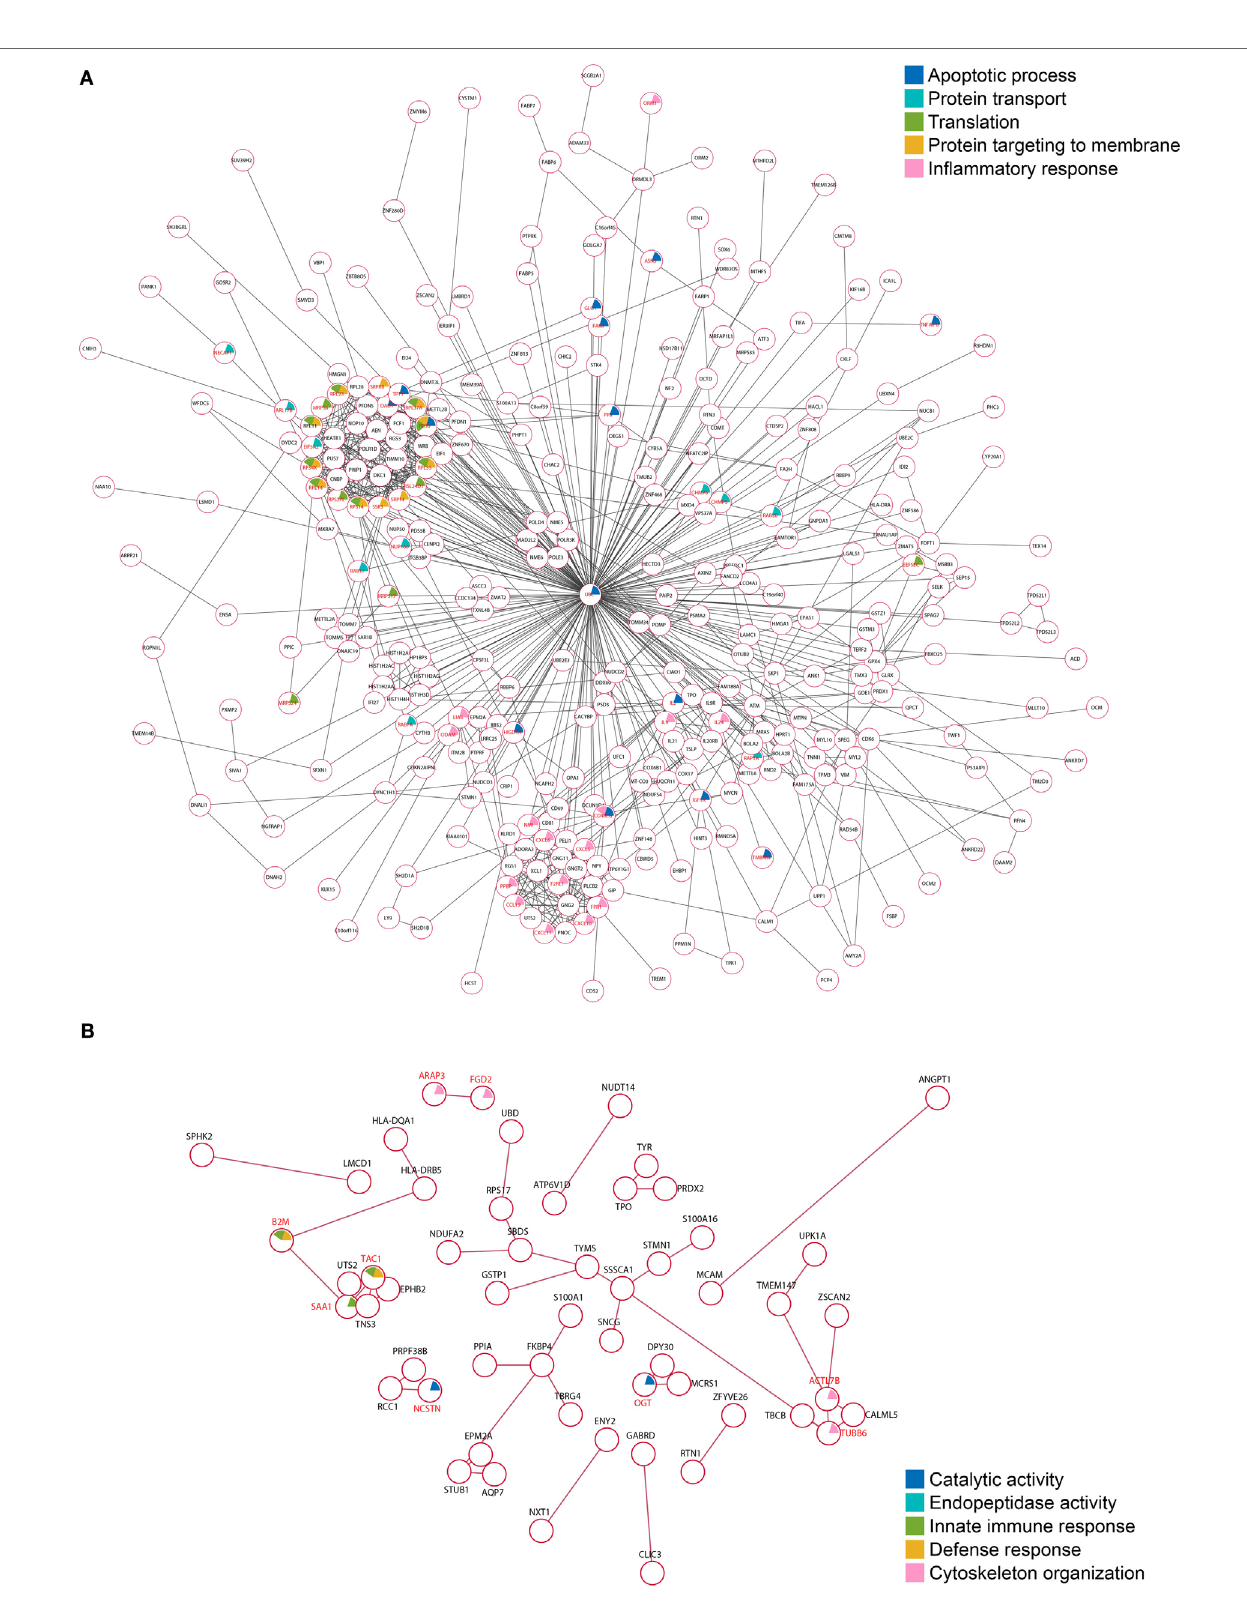
FigUre 5 | Protein–protein interaction (PPI) networks of the Tg ROP18-interacting proteins. (a) Among the ROP18 I -interacting proteins, 353 (71.7%) are tied to a single large network with 785 edges. (B) Among the ROP18 II -interacting proteins, 55 (39.0%) are enriched in a PPI network with 44